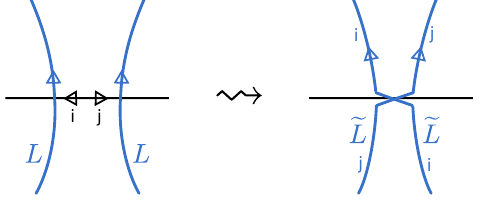
Figure 16 . A lift including an exchange connecting two segments of L which cross the same ij -leaf.